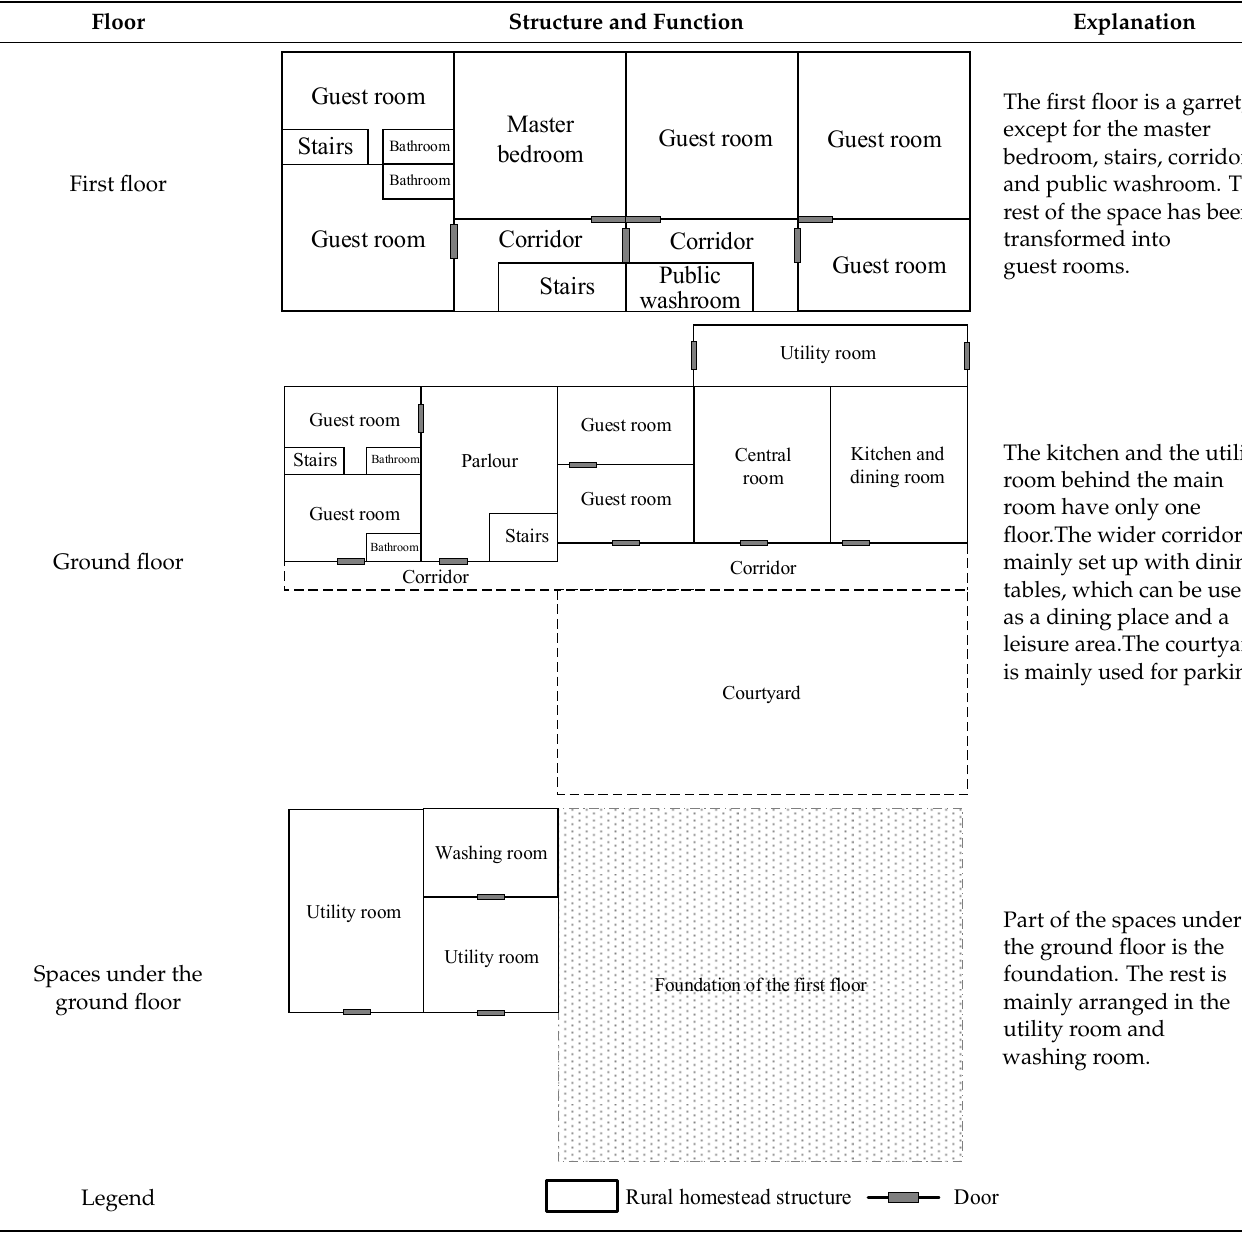
Table 4. The internal structure and function of the homestead after the operation of the homestay in Xiniu village.